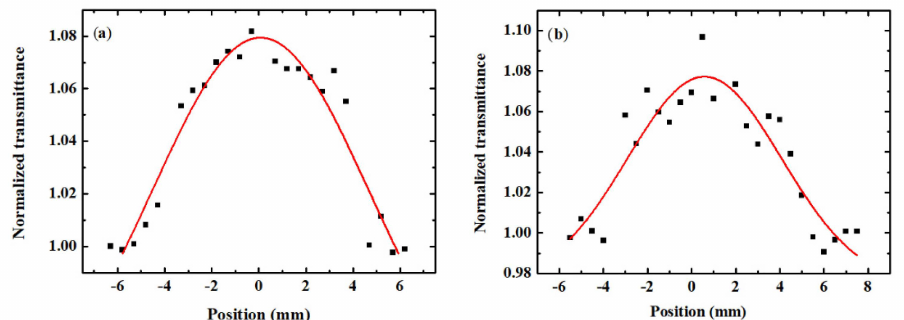
Figure 5. Normalized transmittance as a function of the position of the probe beam inside the laser annealed zone in the case of the ( a ) TF1 and ( b ) TF3 samples.